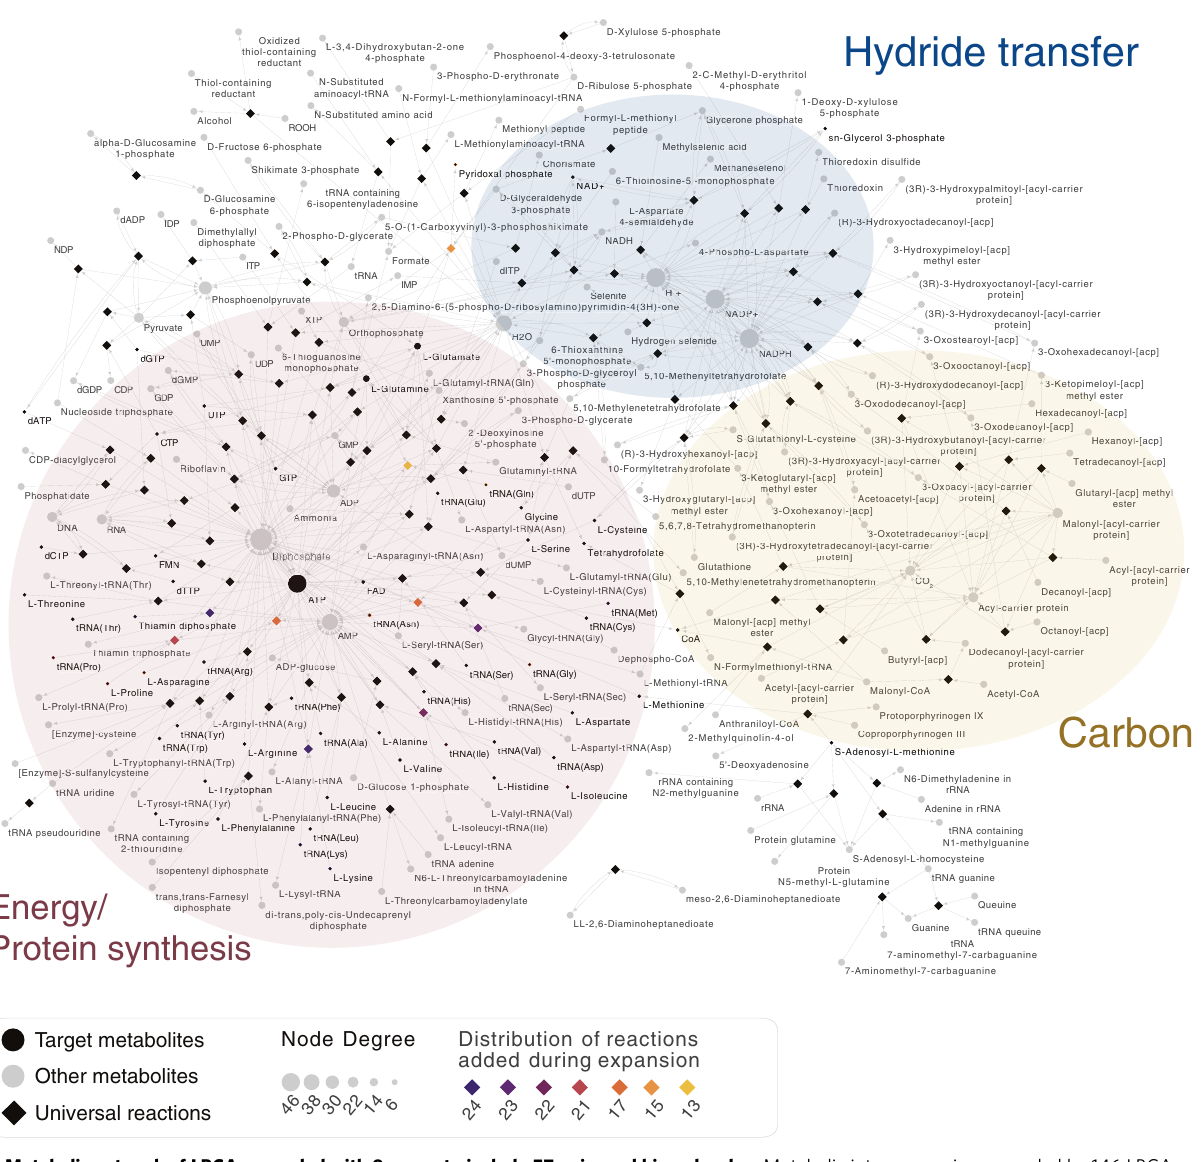
Fig. 1 Metabolic network of LBCA expanded with 9 genes to include 57 universal biomolecules. Metabolic interconversions encoded by 146 LBCA genes plus 9 genes present in fewer groups are shown in a bipartite graph, with 243 metabolites (circular nodes) and 130 reactions (diamond nodes). Black circles represent the 57 universal target metabolites and gray circles represent the remaining metabolites. Note, however, that some of these are also universal (e.g., NADH), but directly connected to the chosen targets (e.g., in that case NAD + ). Node sizes increase according to node degree. Diamonds (reactions) are colored according to the presence of genes encoding for those reactions in different taxonomic groups: in black, reactions present in all taxa; in a gradient from purple to orange reactions added during network expansion and distributed in fewer taxa (target compounds are highlighted with the same outline color if they were introduced with network expansion). Transparent colored ellipses highlight the core of energy (red) hydride transfer (blue) and carbon (yellow)